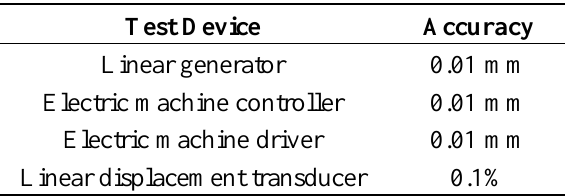
Table 4. The test devices and their